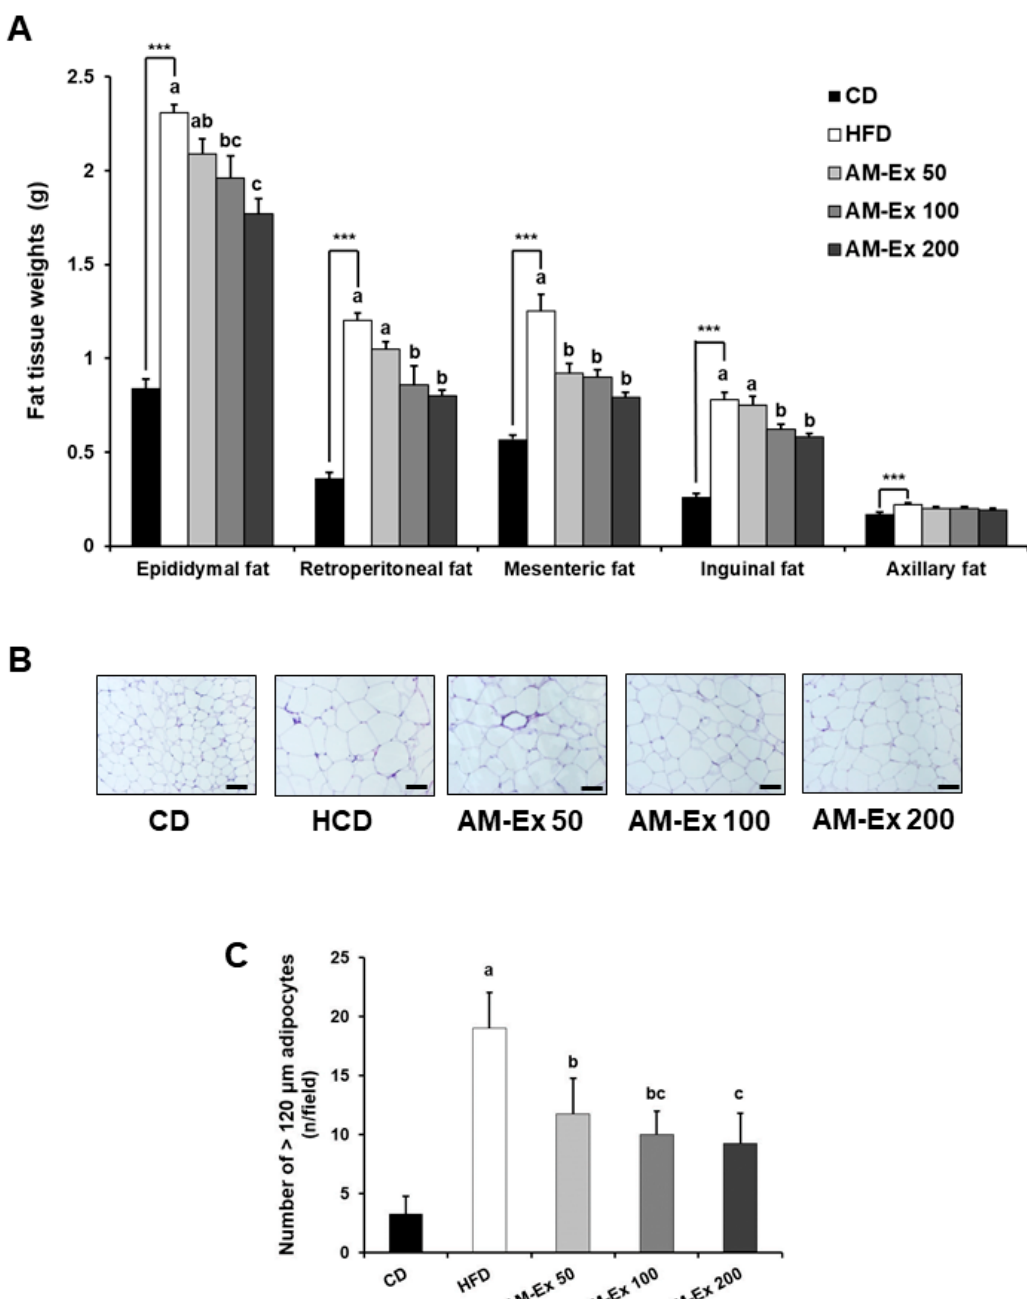
Figure 2. Effect of AM-Ex administration on weight of various adipose tissues and morphological changes in epididymal adipose tissue in HFD-fed C57BL/6N mice. AM-Ex was administered by oral gavage for eight weeks to mice fed HFD. (A) Adipose tissue weights in epididymal, retroperitoneal, mesenteric, inguinal, and axillary fat. Each bar represents the mean ± SEM (n = 10). (B) Representative hematoxylin and eosin (H&E) stained images of epididymal adipose tissues (n = 10). (C) The number of adipocytes over 120 μ m was counted. Each bar represents the mean ± SEM (n = 10). 200 x magnification, Scale bar = 100 μ m. * P < 0.05, ** P < 0.01, *** P < 0.001 significantly different from the CD group. Means without a common letter differ between HFD, AM-Ex 50, AM-Ex 100, and AM-Ex 200 groups at P < 0.05.